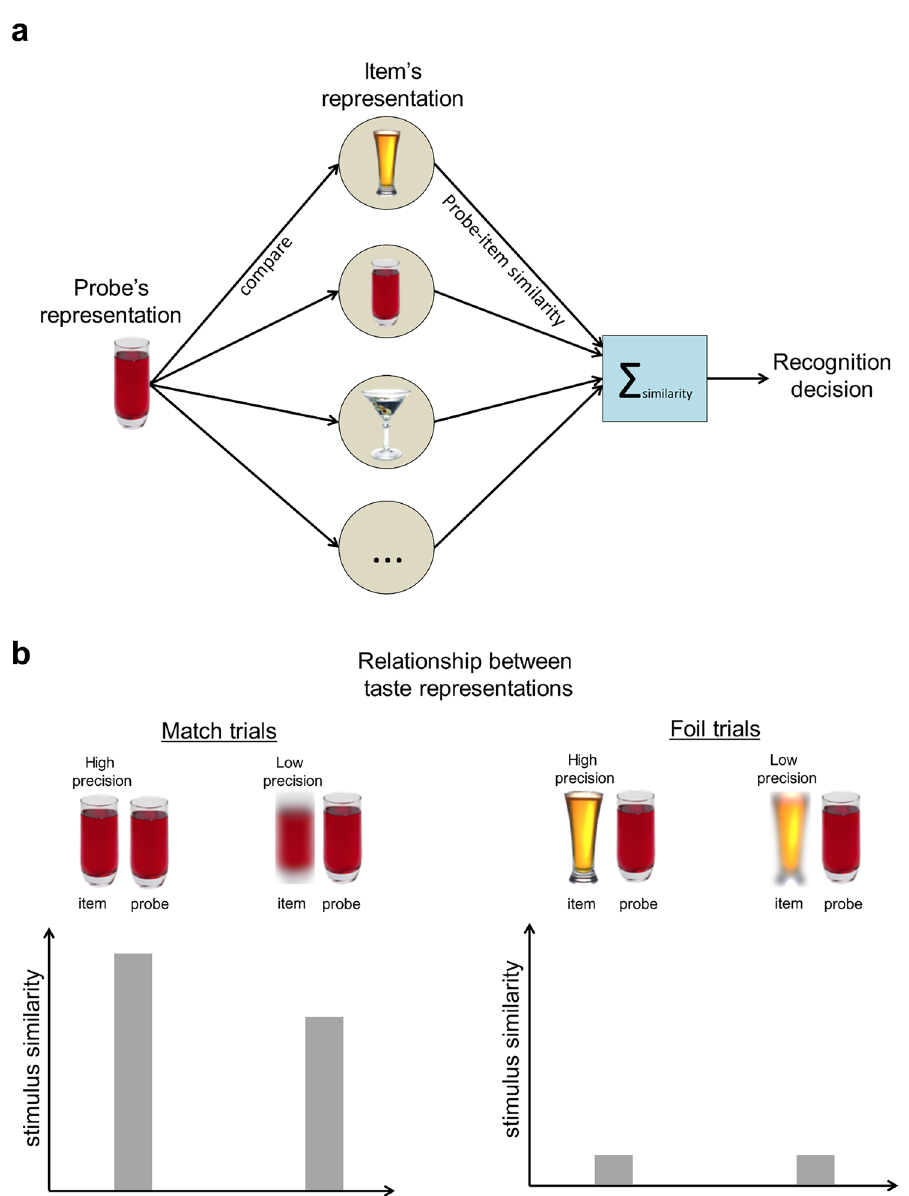
Figure 6. Stimulus similarity. ( a ) When the probe is compared to each item in a set, this comparison estimates these representations’ similarities. These similarity values are then summed together and compared against a decision criterion. ( b ) Left panel: for the match trials, when the item has high precision, there should be a high similarity to the probe’s representation. Conversely, the relative reduction in the precision of the item’s representation should lower the probe-item similarity. Right panel: for the foil trials, it is assumed that the probe-item similarity might already be low. Hence, any reductions in the precision might not further lower this